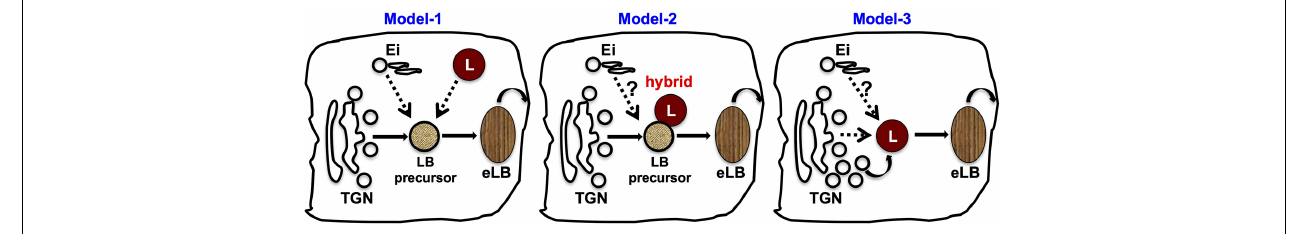
FIGURE 4 | Current models for the biogenesis of epidermal LBs. Based on the existing cargo/membrane transport routes to eLBs, we propose three variant mechanisms for the biogenesis of eLBs in the upper spinosum and granulosum layer keratinocytes. Model-1: LB precursors are derived from the TGN, which mature into functional eLBs upon receiving the cargo/membranes from early/recycling endosomes (Ei) and epidermal lysosomes (L) in a sequential manner. Model-2: TGN-derived LB precursors fuse with epidermal lysosomes and form hybrid organelles, which then mature into eLBs. The cargo transport from the early/recycling endosomes (Ei) to this hybrid organelles is not clear in this model. Model-3: The epidermal lysosomes of the spinosum layer mature into eLBs upon constant fusion of TGN-derived vesicles. As similar to model-2, the input from early/recycling endosomes (Ei) is not clear in this pathway. In all the three models, the matured eLBs fuse with the plasma membrane to deliver its content for the formation of lipid sheets at the